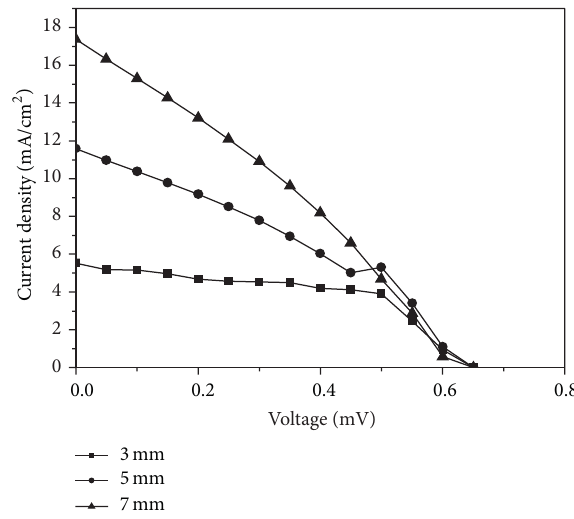
Figure 12: Photovoltaic curves ( J-V ) of the inclined 3D DSSC pre- pared with a graphite counter electrode.